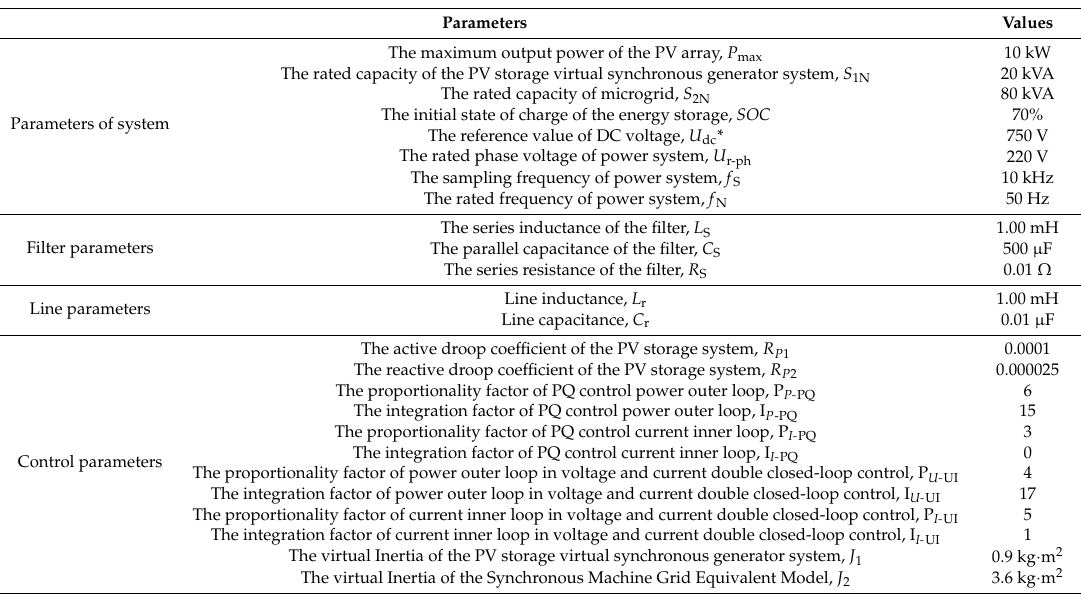
Table 1. Table of simulation parameters.